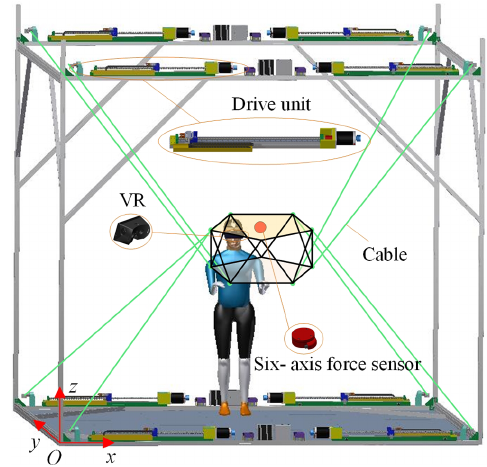
Figure 5. Space configuration of